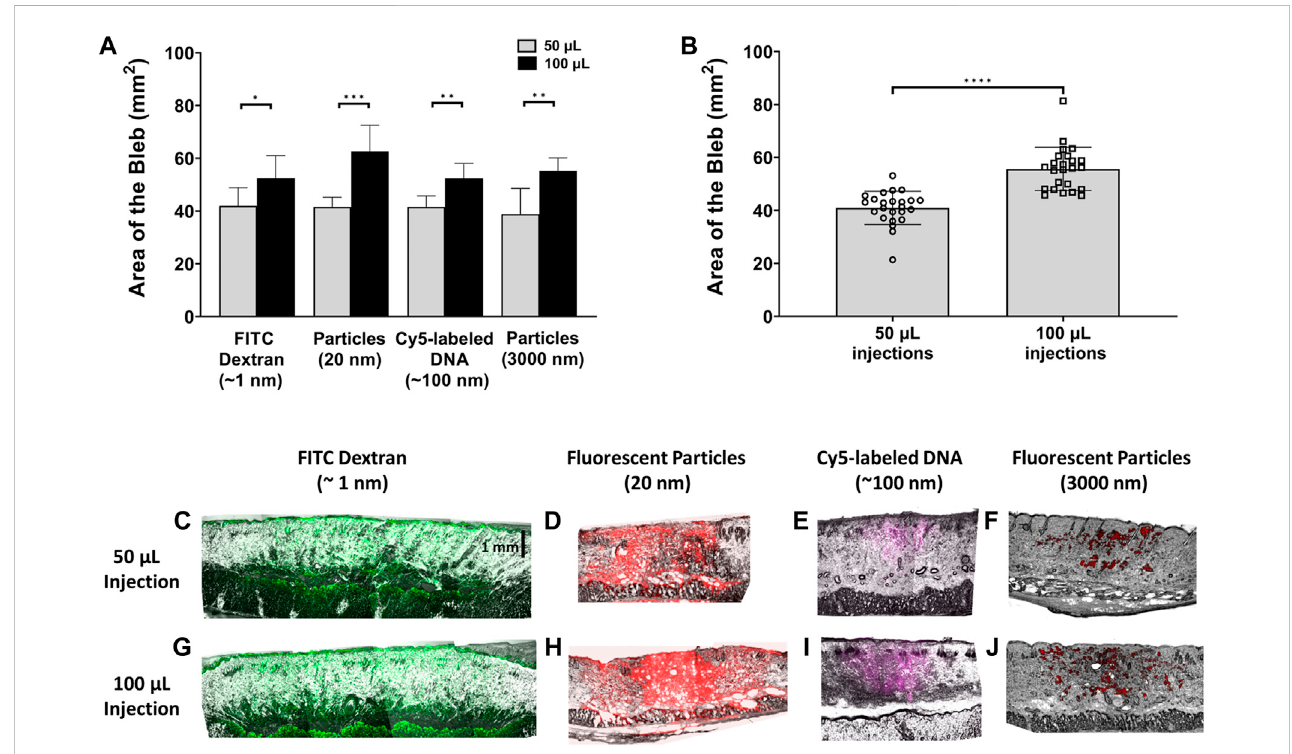
FIGURE 3 Quanti fi cation of bleb area and cargo depth with respect to injection volume. (A) Bleb area comparison for 50 μ L and 100 µL injections. n = 6 each. (B) Area of injection bleb for 50 μ L and 100 µL volumes, combining the areas of all injected materials for each respective volume. n = 24 each. Data represents mean ± SD. * p ≤ .05, ** p ≤ .01, *** p ≤ .001, and **** p ≤ .0001 by Student ’ s t-test. Panels (C – J) represent photomicrograph of fl uorescent signal in vertically sectioned skin samplespost IDinjection.Images werecollected with a×4 objective for 60-µmthick ratskin sections post50 µL (C – F) and100 µL (G – J) injections of the different cargo molecules/particles.